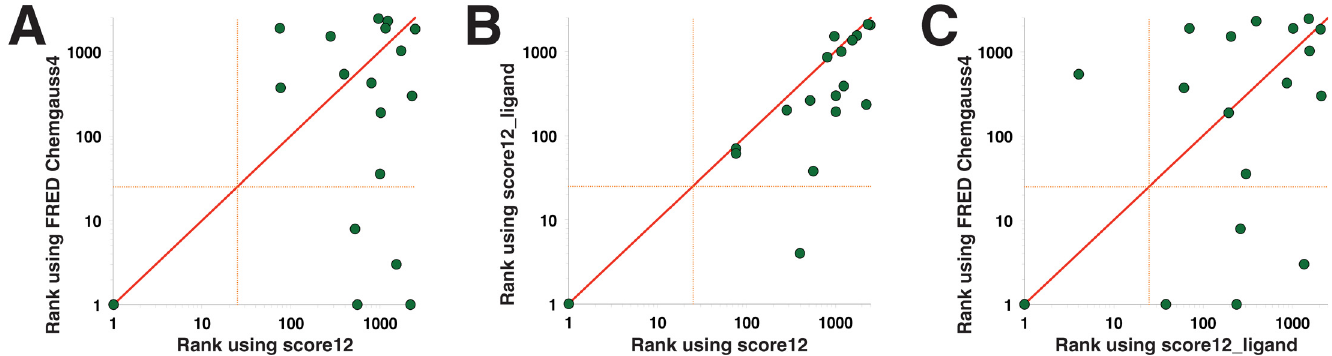
Fig 2. Baseline performance of the Rosetta energy function prior to recent enhancements. Each plot compares the performance of two different scoring functions for identifying the active compounds in our virtual screening benchmark. Each of the 18 protein targets corresponds to a single point ( green dots ); the rank of the active compound (relative to 2500 diverse “ decoy ” compounds) by each scoring function is indicated. The orange dotted line indicates a ranking of 25, corresponding to the top 1% of the decoy set. (A) FRED ’ s Chemgauss4 energy function outperforms Rosetta ’ s original energy function intended for protein-only systems, score12, but not at a statistically significant threshold (p = 0.085). (B) The variant of the score12 energy function that was developed specifically for modeling protein-ligand interactions, score12_ligand, offers improved performance over score12 (p = 0.001). (C) FRED ’ s Chemgauss4 energy function performs at a similar level as score12_ligand (p = 0.239). All p-values are calculated by applying the Wilcoxon Signed-Rank test to the logs of the ranks (see